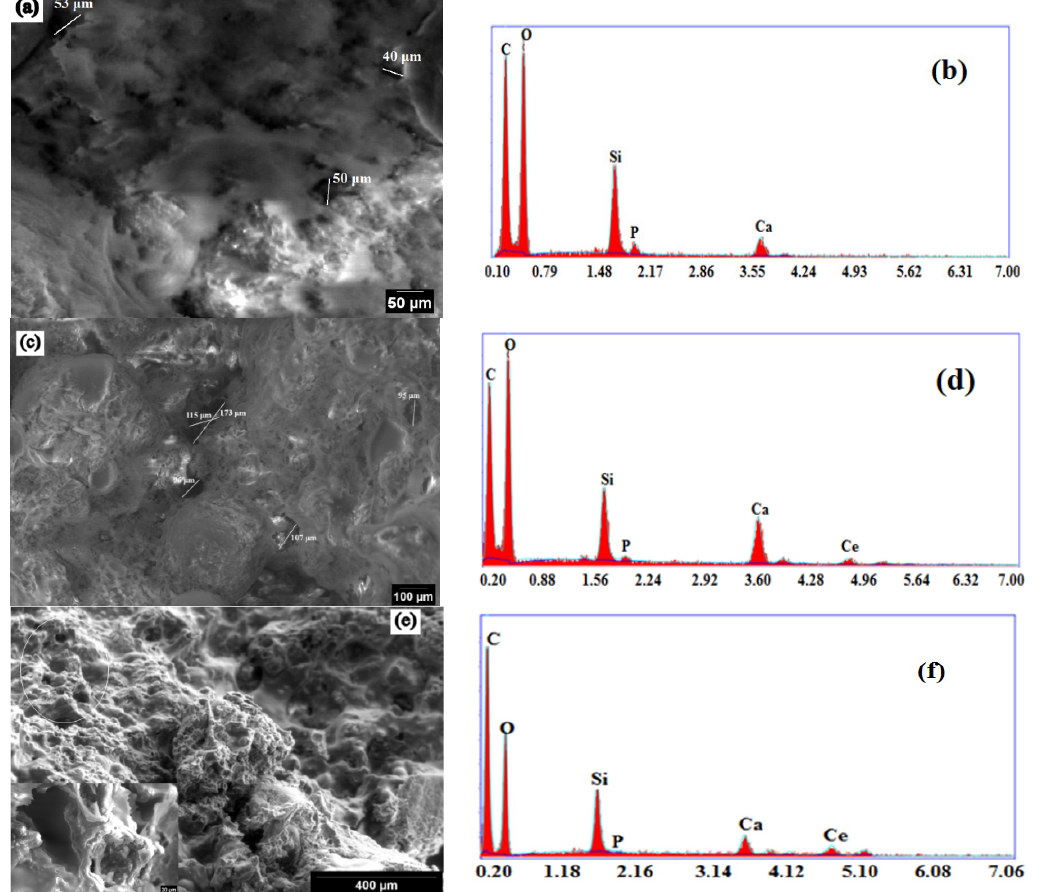
Figure 5. SEM micrographs (different magnifications) and EDX analysis of S0Ce ( a , b ), S1Ce( c , d ), and S3Ce ( e , f ).